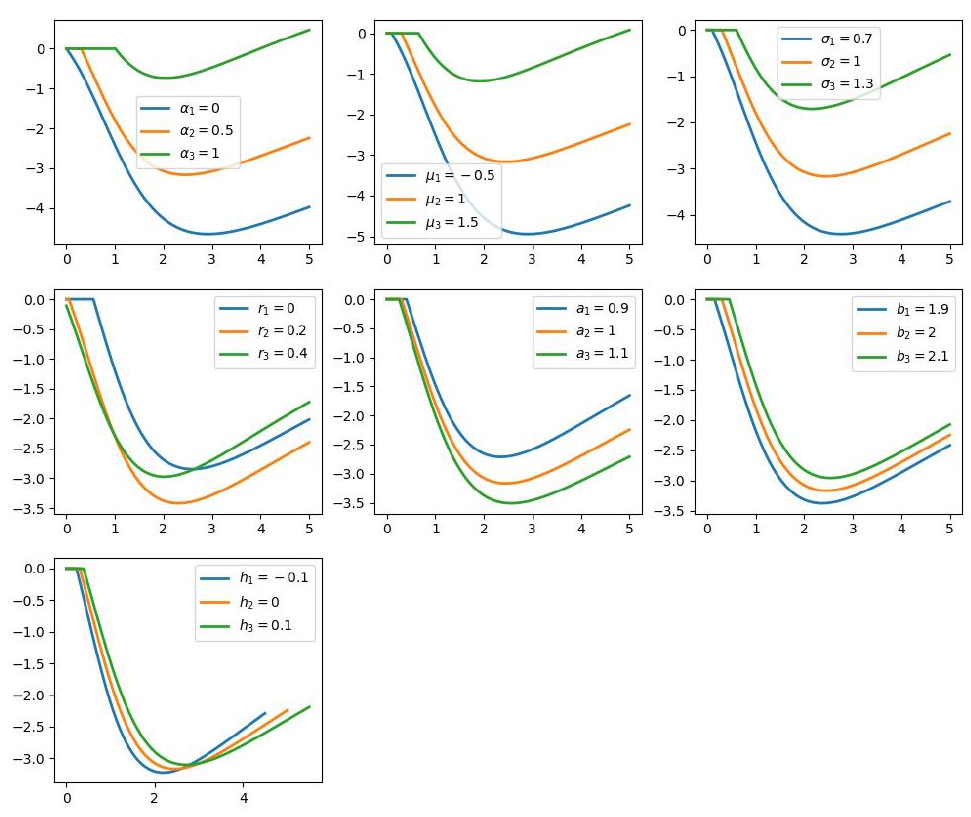
Figure 7. Sensitivity and impulse analysis of the value function of the exponential OU model. for three different values of the parameter. The fixed parameters in each graph are chosen as α = 0.5, µ = 0.2, σ = 1, r = 0.1, a = 1, b = 2, h =